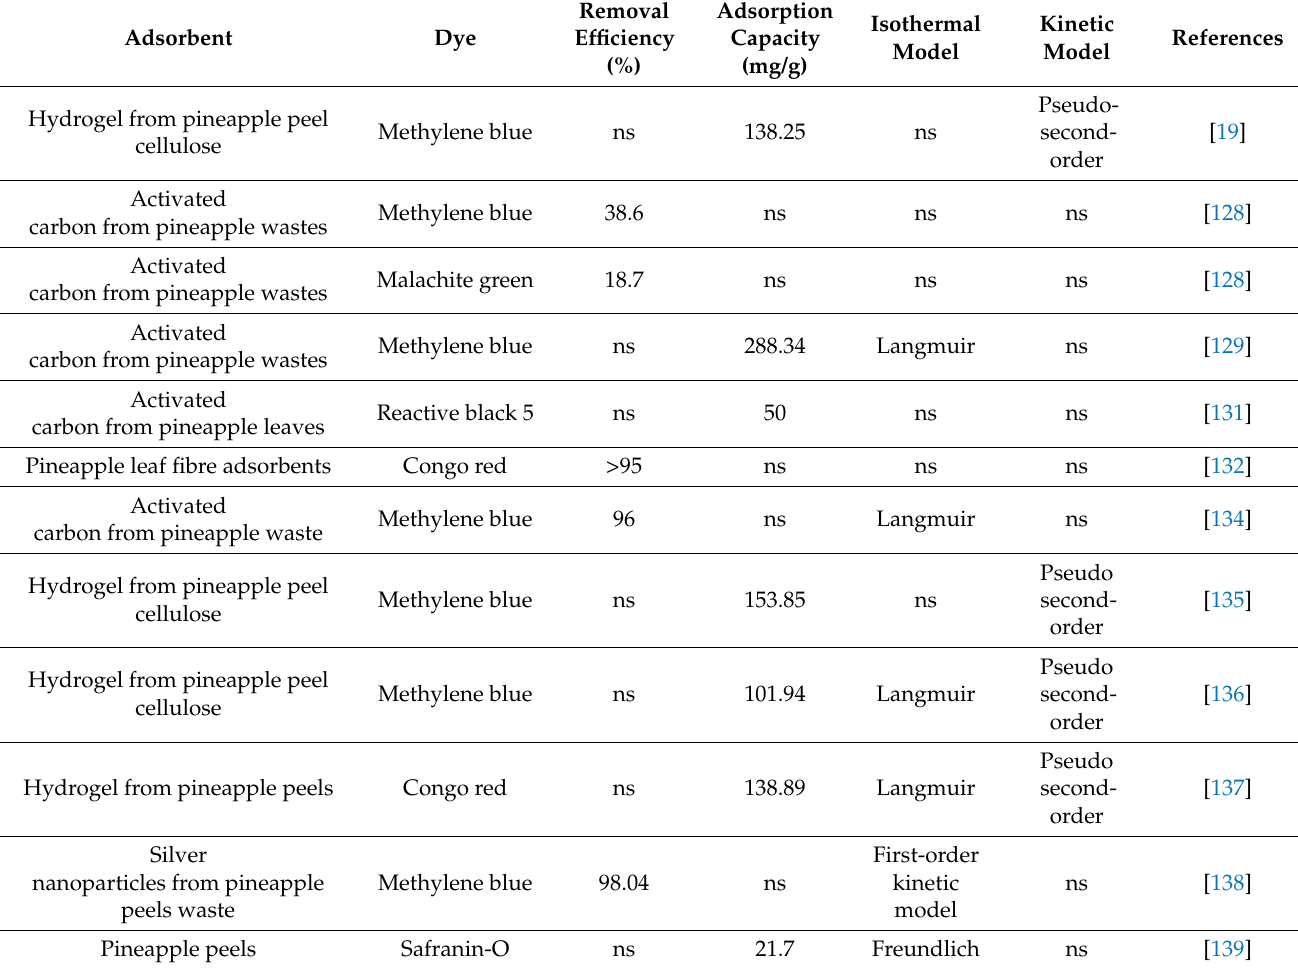
Table 3. Various studies conducted related to the removal of various dyes using pineapple